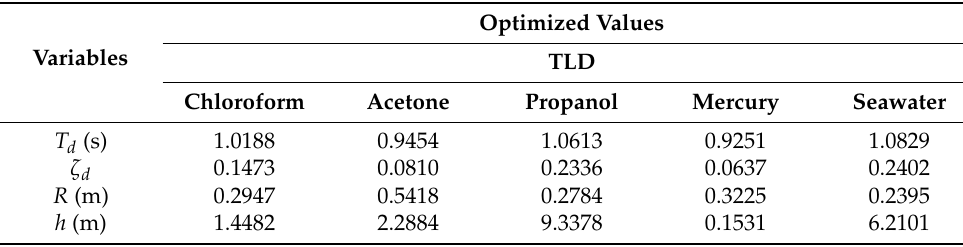
Table 4. Optimum results for all TLD liquids in the single-story structure.